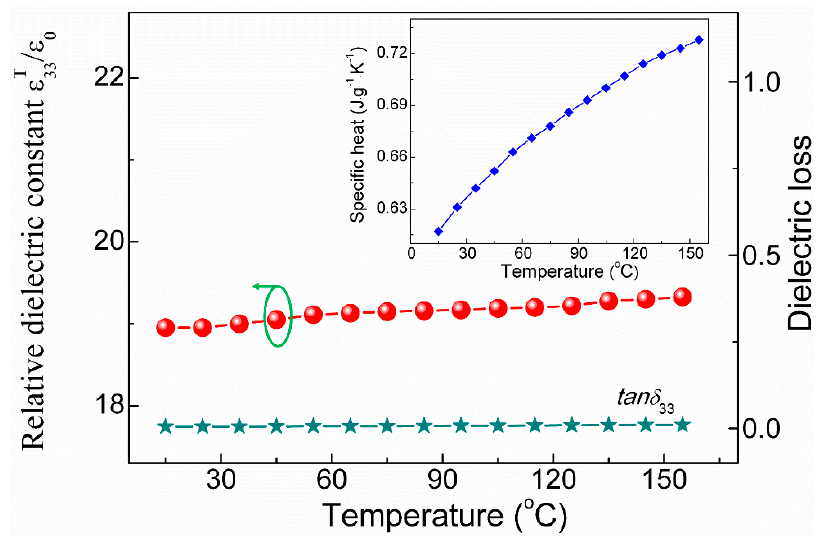
Figure 2. Temperature dependence of relative dielectric constant, dielectric loss and specific heat for BZBO crystals .